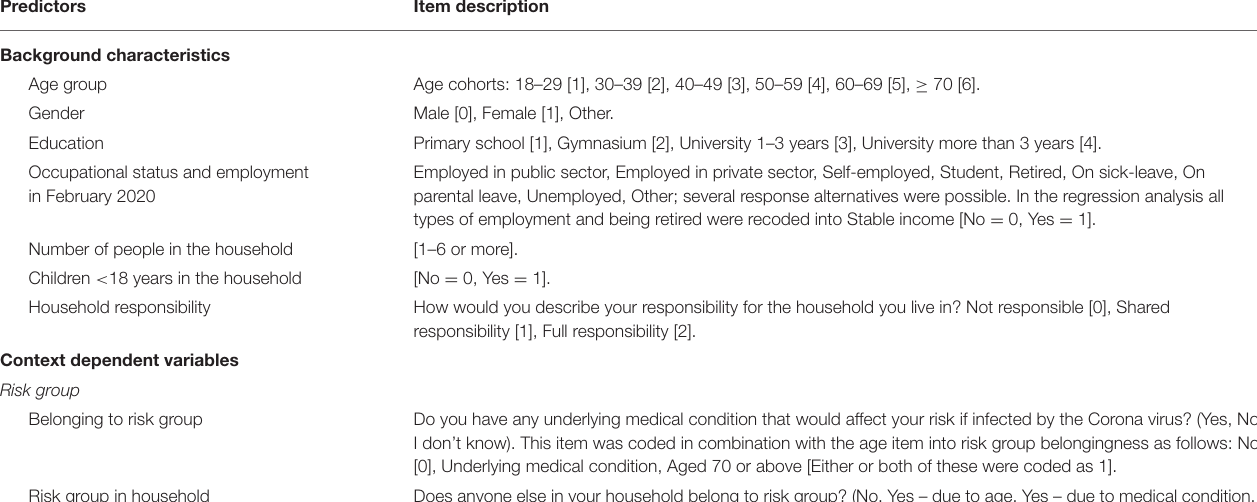
TABLE 1 | Detailed information about the predictor